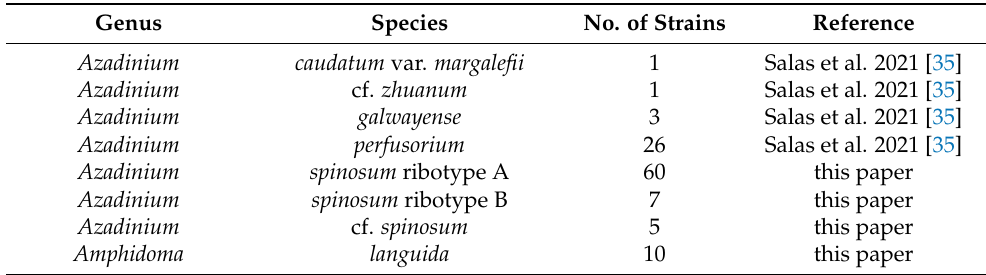
Table 1. Summary of Amphidomataceae strains obtained during the field sample campaign HE516 in summer 2018.